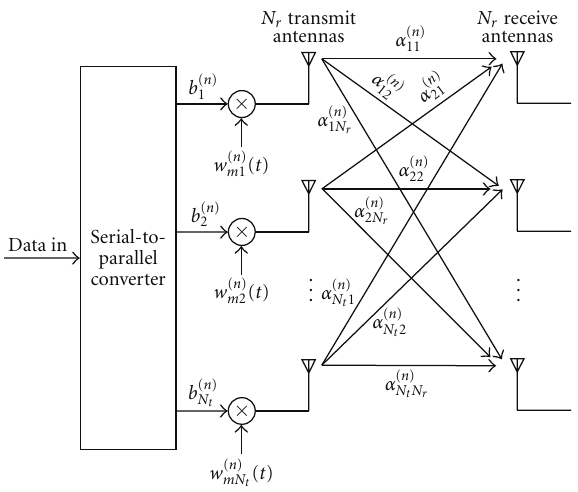
Figure 1: MIMO-CDMA transmitter and link